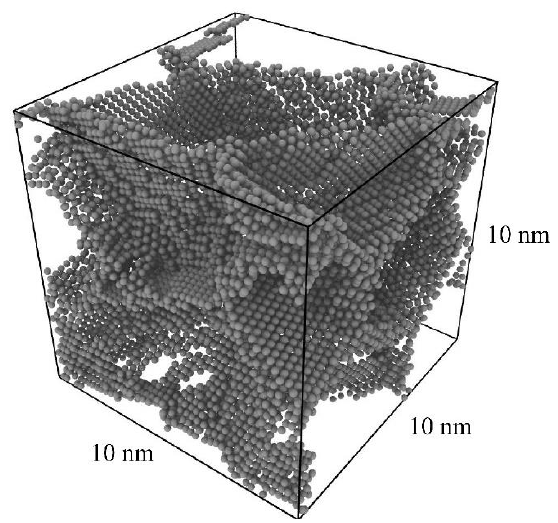
Figure 1. Visualization of the grain boundary network of the pure Al polycrystal after relaxation and annealing, with dimensions of (10 nm) 3 , 10 randomly oriented grains of average diameter 6 nm, and 60,367 total atoms.